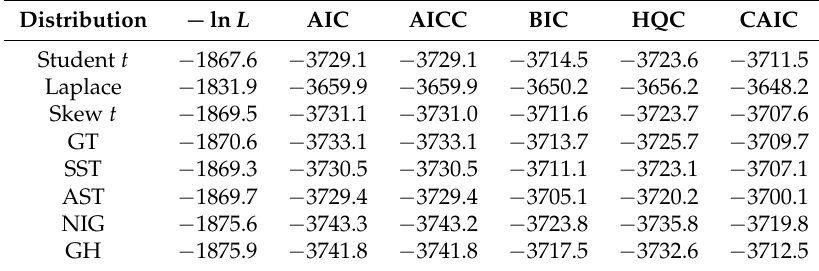
Table 10. Fitted distributions and results for daily log returns of the exchange rates of Ripple